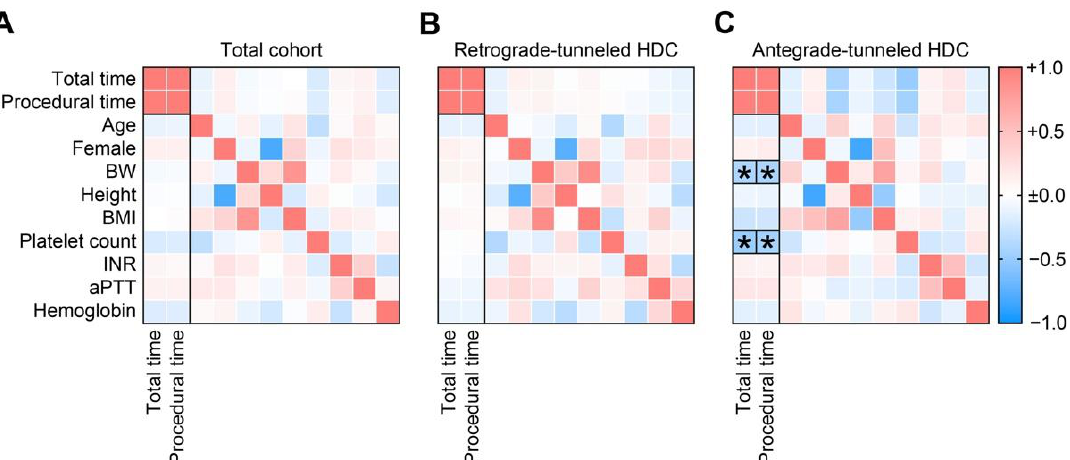
Figure 3. ( A – C ) Correlative analyses of HDC implantation time are shown by the heatmap reflecting mean values of Spearman’s ρ. The rectangle box indicates a Spearman’s ρ more than ±0.4, the asterisk a significant correlation in the multiple linear regression analysis ( p < 0.05). Abbreviations: aPTT, activated partial thromboplastin time; BMI, body mass index; BW, body weight; cm, centimeter; HDC, hemodialysis catheter; INR, international normalized ratio.